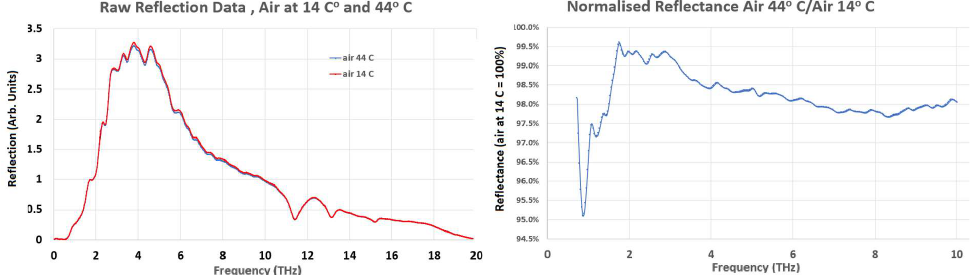
Figure 3. The effect of temperature variation on ATR spectra at 14 °C and 44 °C with no specimen in place. The variation between the 14 °C and 44 °C spectra was not uniform, varying by 0.5% to 5%, depending on the frequency.